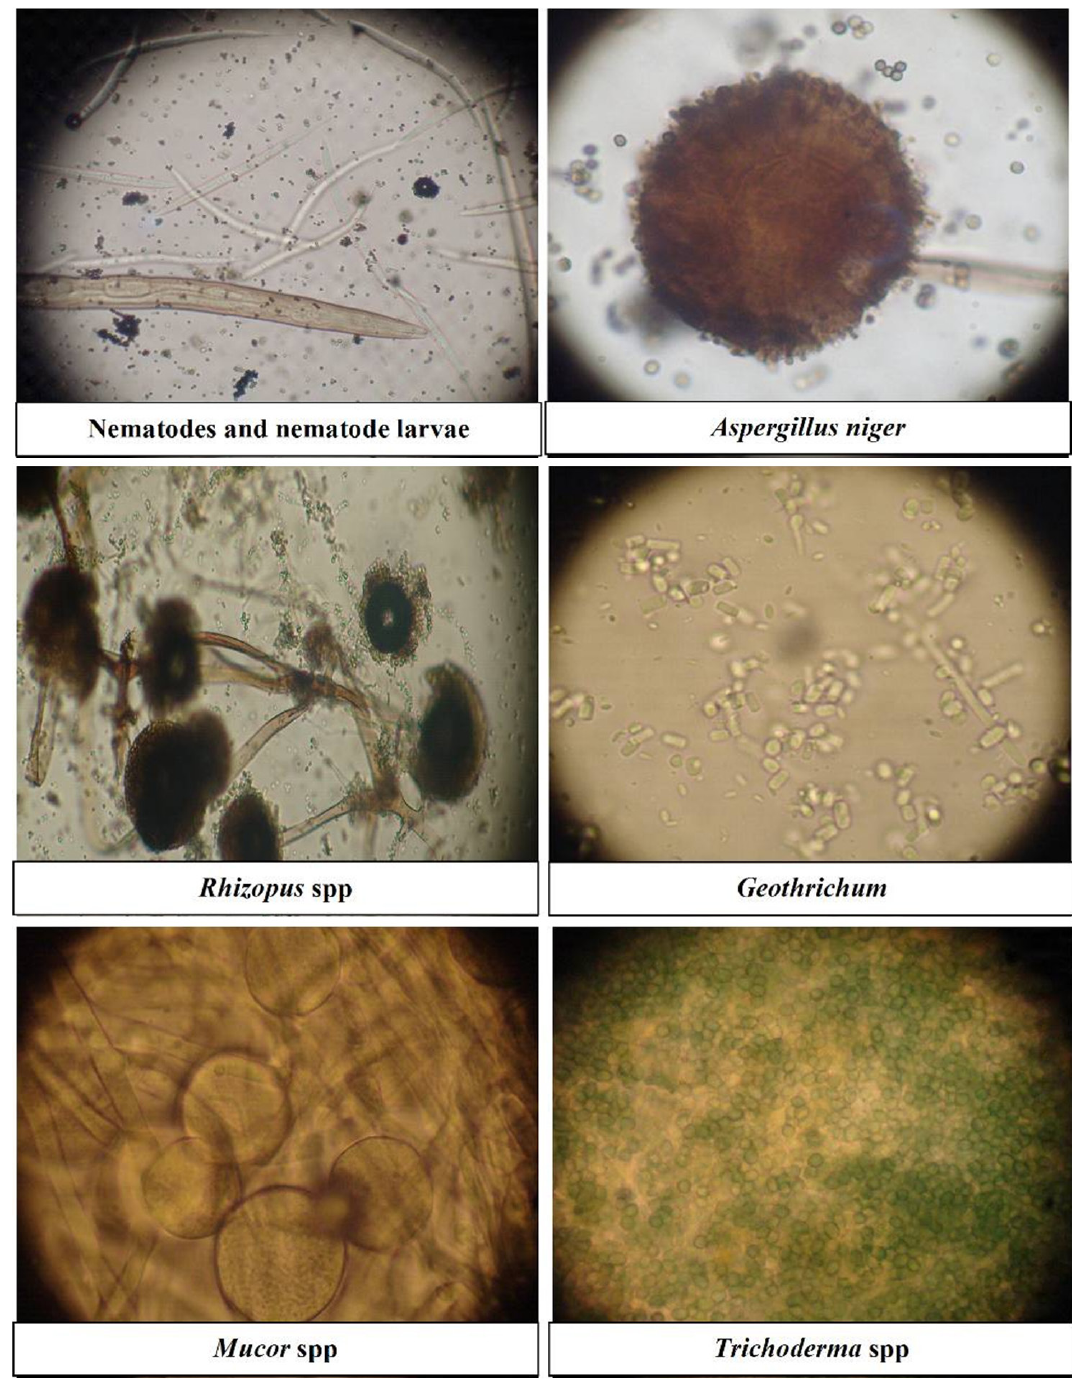
Figure 7. Photographs of the fungi identified in the cleaning water